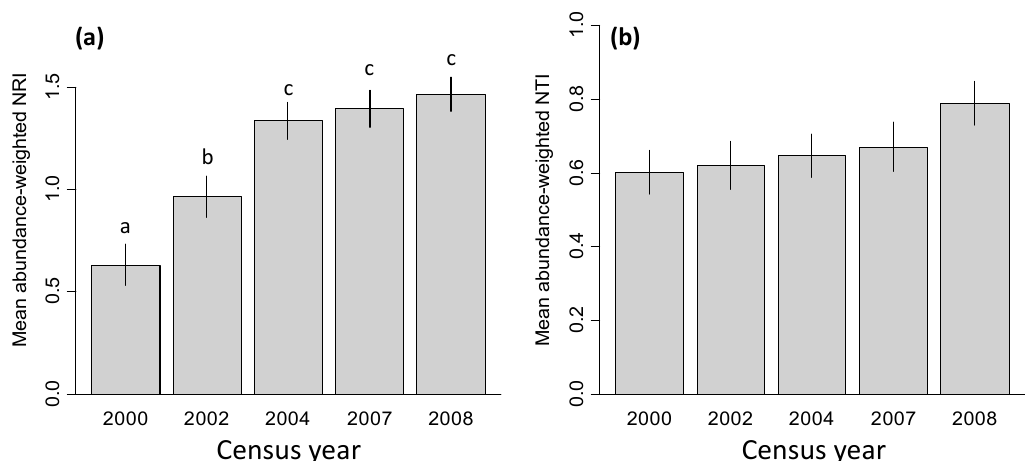
Figure 4. Histograms showing the frequency of log-transformed seed mass values of seedlings in the 150 2 × 1 m seedling plots in the Luquillo Forest Dynamics Plot, Puerto Rico. Each seedling was assigned the mean seed mass value for its species.